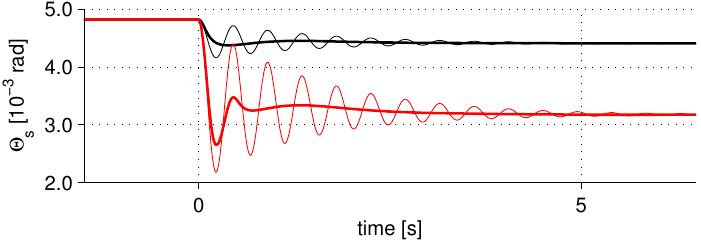
Figure 11. Control performance of active damping systems: Comparison between one (black line) and four total generator failures (red